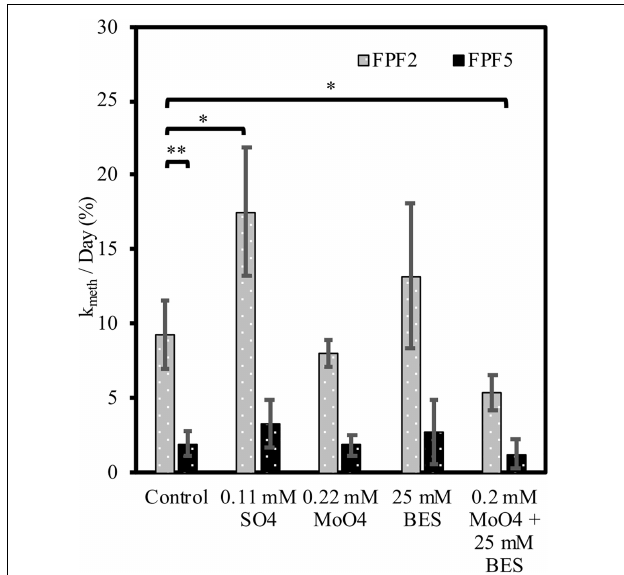
FIGURE 3 | Mercury methylation rates (k meth ) at sites FPF2 (gray bars) and FPF5 (black bars) in 2016. X-axis labels indicate treatment with stimulator or inhibitors of specific microbial guilds. Error bars represent standard deviations. ∗ means p < 0.10, ∗∗ means p <